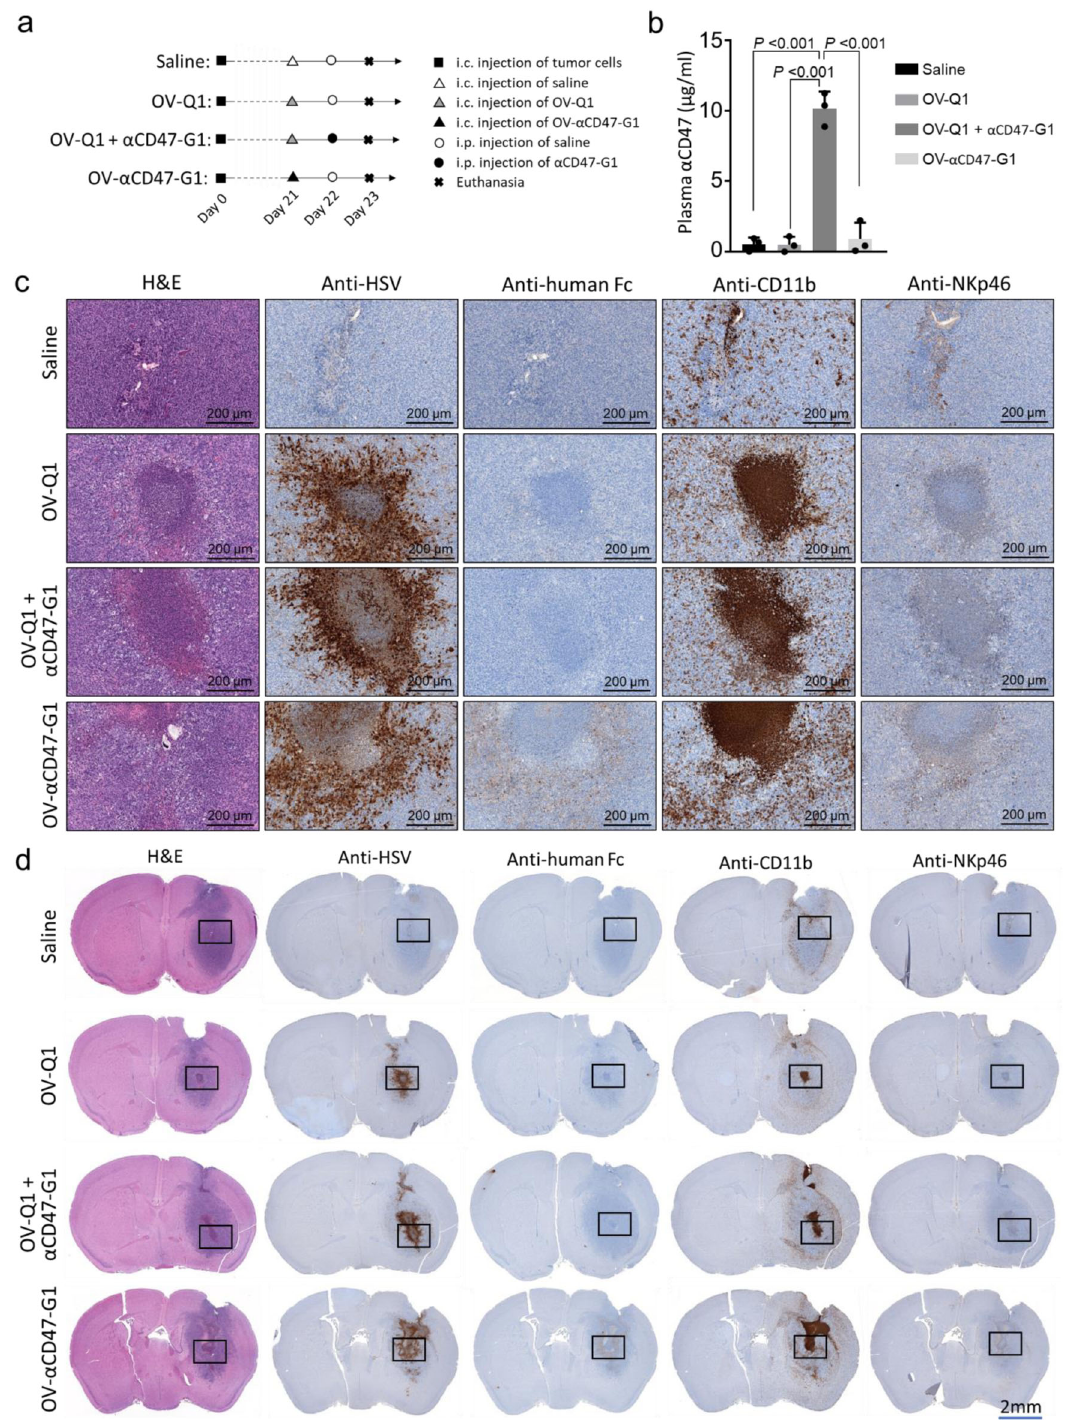
Fig. 4 OV- α CD47-G1 is effective for locoregional delivery of the anti-CD47 antibody, while systemic administration of α CD47-G1 is not effective. a Experimental timeline for in vivo studies using an orthotopic model of human GBM. Experiment details are provided in the main text. Group 1, saline; Group 2, OV-Q1; Group 3, a combination of OV-Q1 plus i.p. administration of α CD47-G1; and Group 4, OV- α CD47-G1. After tumor implantation, Groups 2, 3 and 4 received intracranial injection of oHSV (OV-Q1 or OV- α CD47-G1) at a dose of 2 × 10 5 PFU per mouse on day 21. Group 1 received saline as control. On day 22, Group 3 received i.p. injection of puri fi ed α CD47-G1 at the dose of 150 µ g per mouse. Groups 1, 2, and 4 received i.p. injection of saline as control. All mice were euthanized on day 23 for blood and brain harvesting. b The concentration of α CD47-G1 in plasma measured by ELISA in mice from different treatments. One-way ANOVA with P values corrected for multiple comparisons by the Bonferroni test ( n = 3 animals). c , d Slides from the brain tissues isolated from experimental mice were subjected to H&E and immunohistochemical staining, the latter with anti-HSV, anti-human Fc, which identi fi es IgG, anti-CD11b or anti-NKp46 antibodies. Images with high and low magni fi cations are shown in ( c ) and ( d ), respectively. The boxed images in ( d ) are shown in higher power in ( c ). Data presented are representative of one ( c , d ) or three ( b ) mice of at least three mice in total with similar data. Data in ( b ) are presented as mean values ±